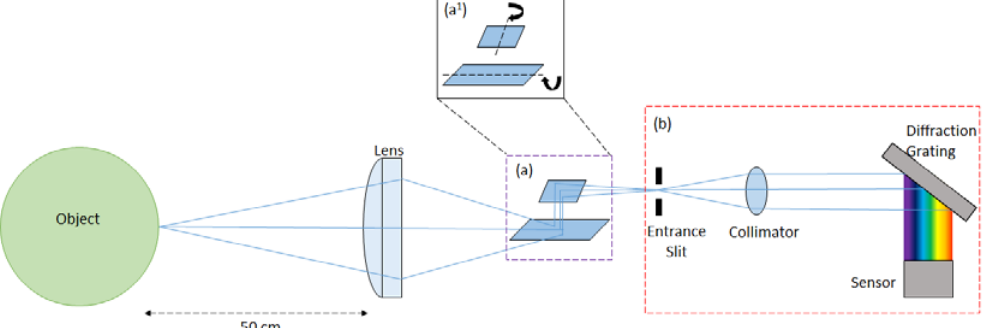
Figure 2. Schematic diagram of the low-cost hyperspectral imager: ( a ) and ( b ) comprise the rotary mirror system and the miniature spectrometer respectively, illustrating the main components of each device. Inset ( a 1 ) displays the rotational axis for each mirror. Note, beam steering of the field of view (FOV) is provided by the mirrors. The image distance is ca. 66.6 mm. This is distributed as follows: ca. 30 mm lens to mirrors, ca. 4.6 mm between mirrors, and ca. 32 mm mirrors to spectrometer. Not to scale.